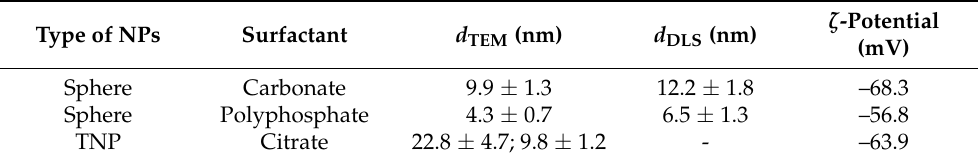
Figure 1. TEM images of polyphosphate ( a ), carbonate ( b ), and plate ( c ) NPs, respectively. Table 1. The characteristics of silver NPs obtained from TEM and DLS technique. Type of